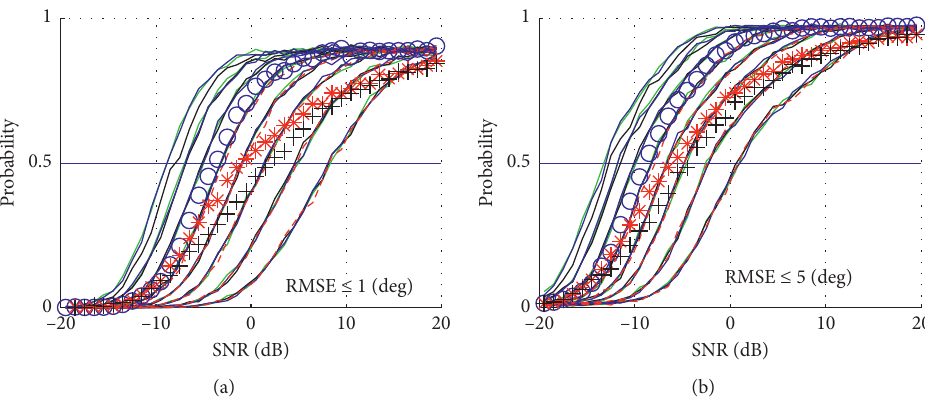
Figure 5: Probability of AoA measurement of Array-3 on 4 different waveforms with M + 1 � 17 , 33 , 65 , 129 , 257 , 513 , and 1025 from right to left in each subplot. Each group of data has 4 curves related to 4 waveforms. ooooo, ∗∗∗∗∗ , and +++++ lines are the results of calculations on WF-4 using 513, 1025, and 2049 snapshots, respectively.